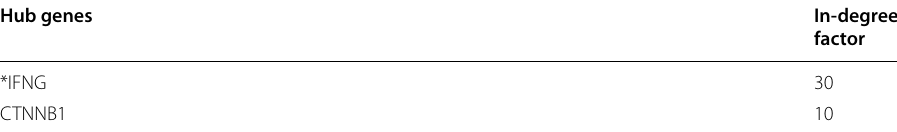
Table 5 The detected hub genes based on the in-degree centrality in the TF-gene interaction network